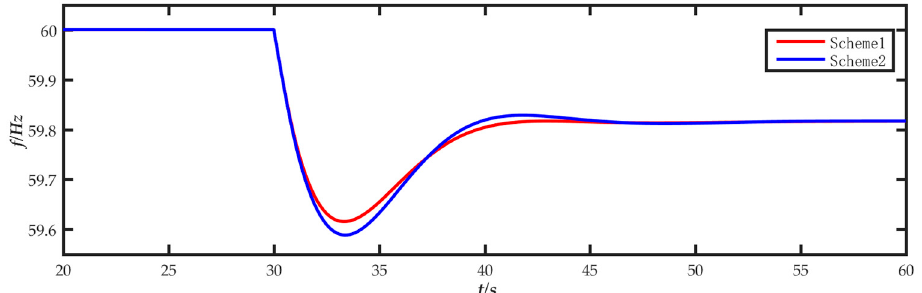
Figure 8. Frequency change in the system.